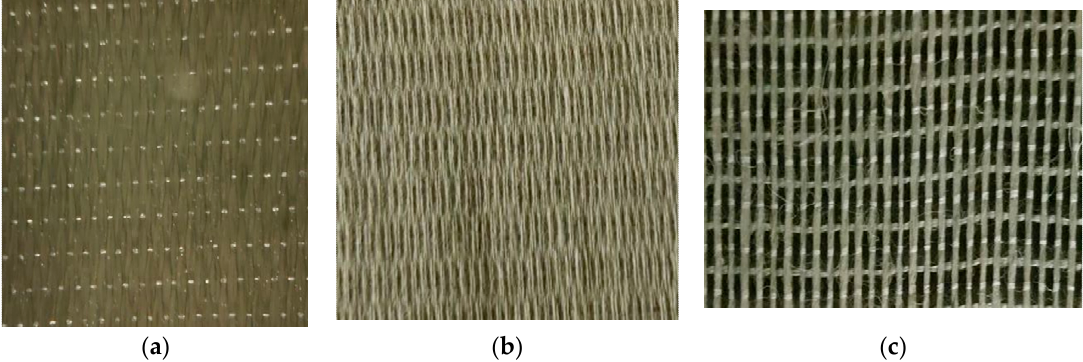
Figure 1. ( a ) Unidirectional carbon fiber; ( b ) unidirectional flax fiber; ( c ) flax and carbon fiber co-woven fabric for intra-ply hybrid composites.